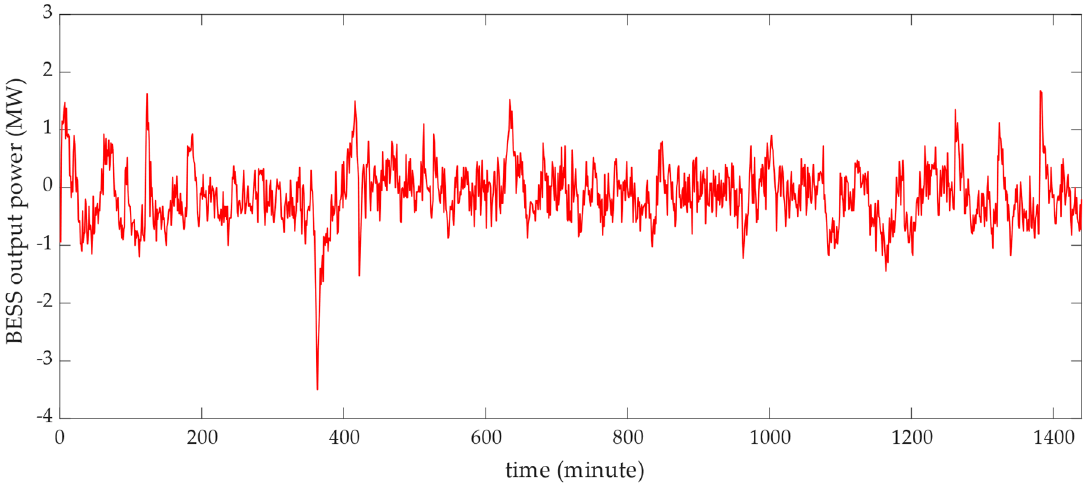
Figure 12. Battery storage power output without DoF strategies. P is given by Equation (2).